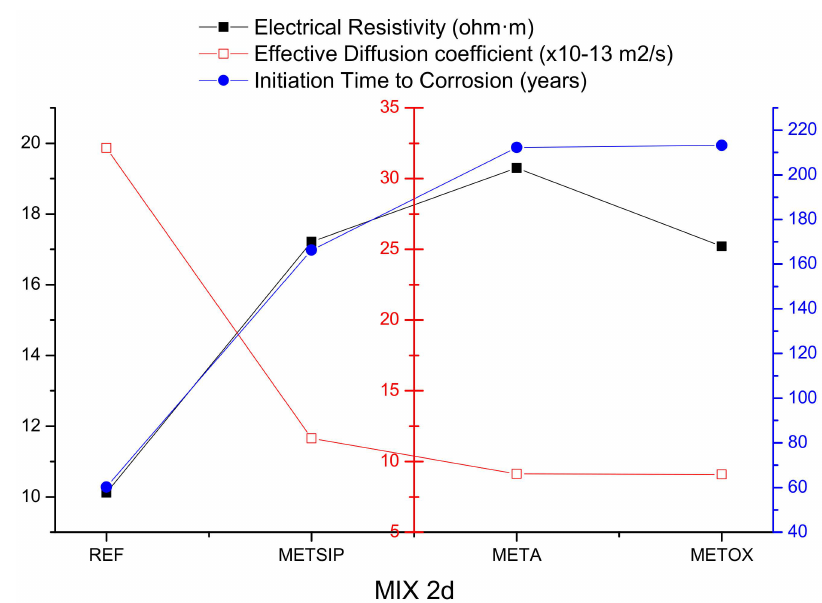
Figure 14. Electrical resistivity, e ff ective di ff usion coe ffi cient, and corrosion initiation time for mixes with two days of curing time.